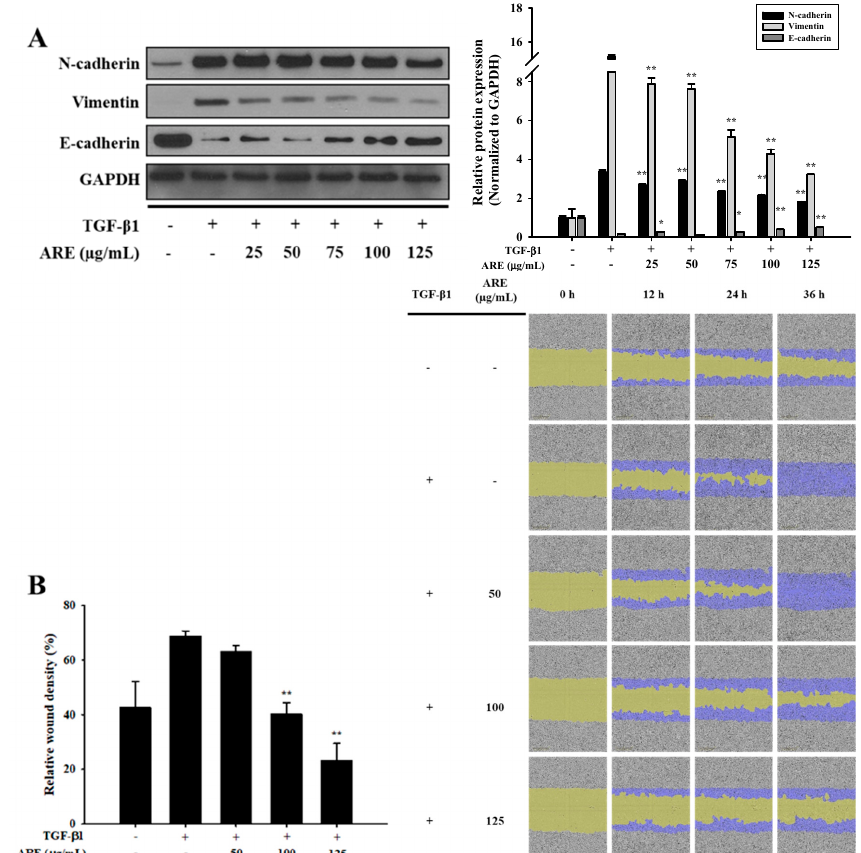
Figure 1. Astilbe rubra extract inhibited TGF- β 1-induced epithelial-to-mesenchymal (EMT) in A549 cells. A549 cells were co-treated with TGF- β 1 and A. rubra extract (ARE) for 48 h. ( A ) The expression of N-cadherin, vimentin, and E-cadherin proteins were analyzed using Western blot analysis, with GAPDH expression used as a loading control. ImageJ was used for the quantification of the Western blots. ( B ) A549 cells were plated into 96-well plates and treated with TGF- β 1 (5 ng/mL) or co-treated with ARE. The cell mobility was analyzed by IncuCyte ZOOM over 36 h at 10× magnification through a phase-contrast objective lens. The bar graph represents the wound density at 24 h exposure. All data are shown as mean ± S.D., n = 3. ** p < 0.01 vs. the TGF- β 1-treated group.